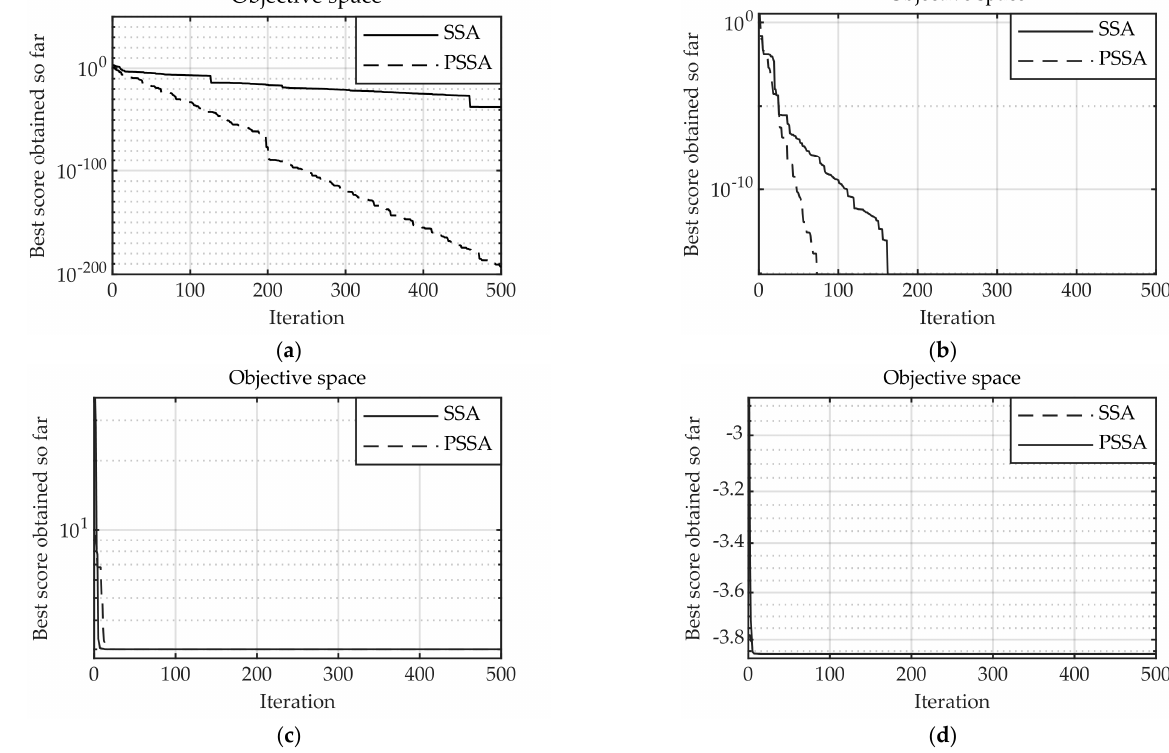
Figure 9. Convergence comparison between SSA and PSSA: ( a ) f 3 ; ( b ) f 10 ; ( c ) f 18 ; ( d ) f 19